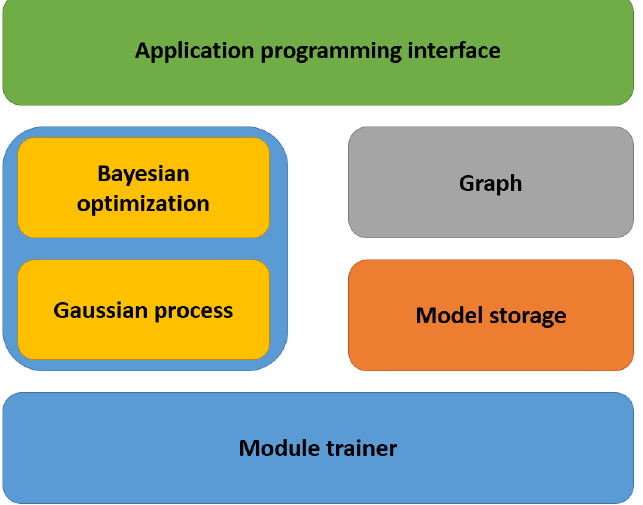
Figure 3. Autokeras system architecture. 1. Initially, the API is called by the user. 2. Then, the Searcher creates NN architectures on the CPU. 3. The graph moduleconstructs the actual neural networks with the parameters on the RAM from the NN architectures. 4. Following this, a copy of the NN is sent to the GPU for training. 5. Finally, the fit NNs are kept on the storage devices, and an update is applied to the searcher according to the training outcomes. Repeat Steps 2 to 5 until the time limit is